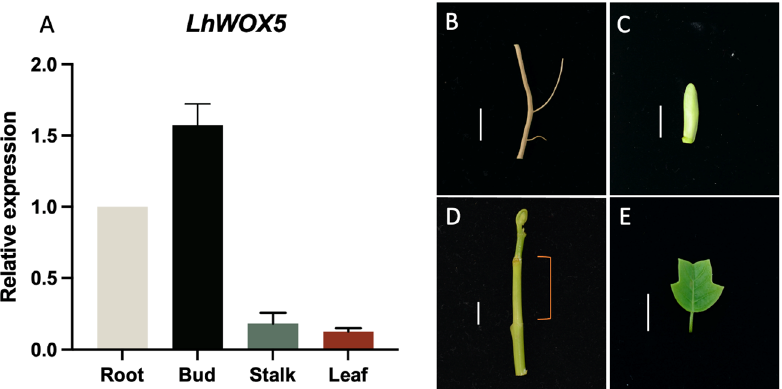
Figure 2. Relative expression of LhWOX5 in Liriodendron hybrids. ( A ) Relative expression levels of LhWOX5 in different tissues. ( B – E ) Different tissues were collected from 3-month-old plants for qRT-PCR, indicated as ( B ) root, ( C ) bud, ( D ) stalk (only the orange area was used for sampling), and ( E ) leaf. Scale bars = 1 cm.